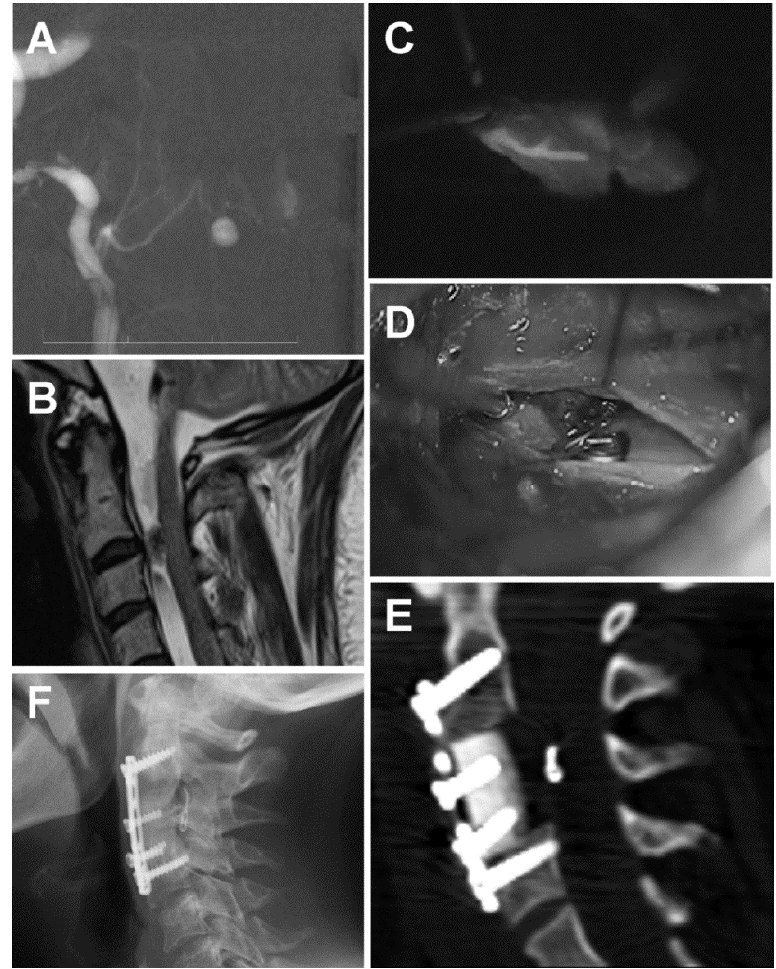
Figure 2. Spinal aneurysm associated with a ventral cervical arterio-venous (AV) fistula ( A ) AV fistula associated with an aneurysm displayed with a super-selective digital subtraction angiography (DSA). ( B ) Sagittal T2W MRI showing a lesion ventral to the spinal cord at the C2/3 level. ( C ) Perioperative indocyanine green (ICG) showing the pedicle feeding a type IVA ventral AV fistula from the anterior spinal artery. ( D ) Perioperative microscopic image after clipping the AV fistula. ( E ) Tibial bone allograft with a titanium plate and bicortical screws after C3 somatectomy. The clip is visible in front of the spinal cord, just in the middle of the approach. ( F ) The X-ray image shows the complete fusion of the allograft with the cervical bodies.